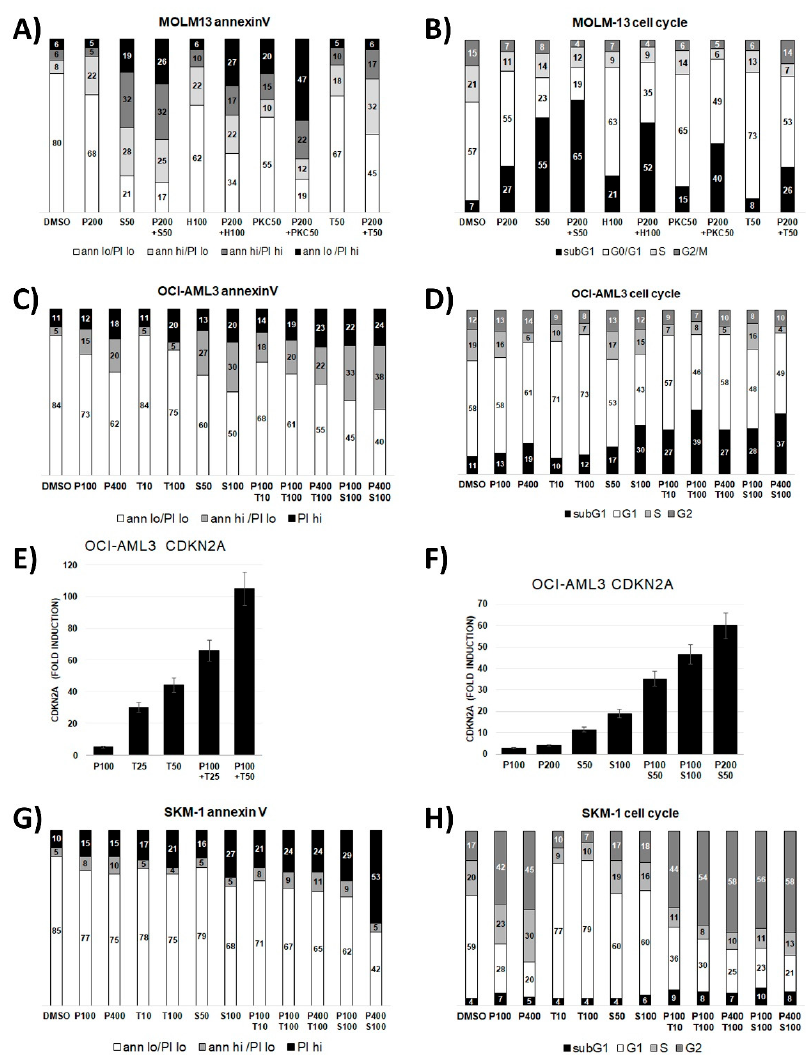
Figure 4. Dose-dependent induction of apoptosis and cell death in AML cells treated with PTC596 alone and in combination with targeted compounds. Cytometric analysis in AML cells treated for 20 h with PTC596 alone and in combination with PTC596 (P), S63845 (S), HDM201 (H), PKC412 (PKC), trametinib (T) to measure induction of apoptosis using annexinV and PI staining, induction of cell cycle arrest and cell death (subG1 fraction) using DAPI staining in MOLM-13 ( A , B ); OCI-AML3 ( C – F ); and SKM-1 ( G , H ). Relative quantitation of CDKN2A mRNA in OCI-AML3 cells treated for 20 h with PTC596 (P), S63845 (S), trametinib (T) alone or in combination ( E , F ).